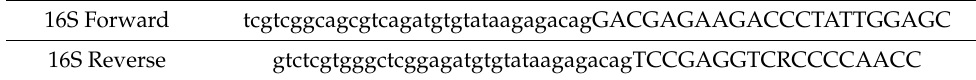
Table 1. The oligodeoxynucleotide sequences of the universal primers for mitochondrial 16S rRNA gene amplification. The letters in small case are Nextera adapter